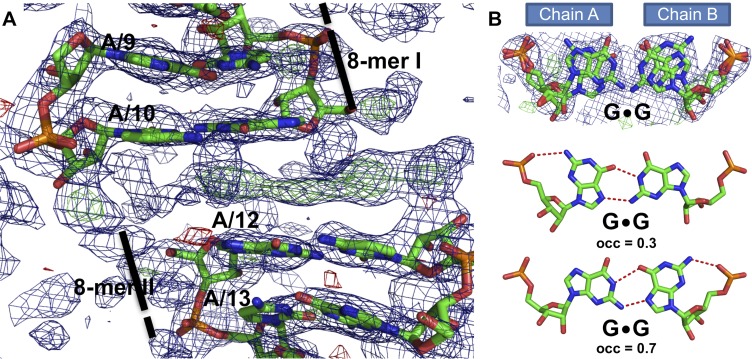
Overview of RNA II structure.(A) Molecular replacement solution with two 8-mer molecules in stick representation, and respective electron density (2Fo-Fc map) contoured at 1.0σ level–blue mesh. The FoFc maps contoured at the 3.0σ level are shown in green and red meshes. Nucleotide labels correspond to chain A of RNA II. (B) The overview of non-canonical G•G base pair at position 10 presents the overlap of the double conformation with electron density and G•G pair with occupancy 0.3, and 0.7. The hydrogen bonds between the bases are shown as red dash lines. The figure was prepared in PyMol [43].